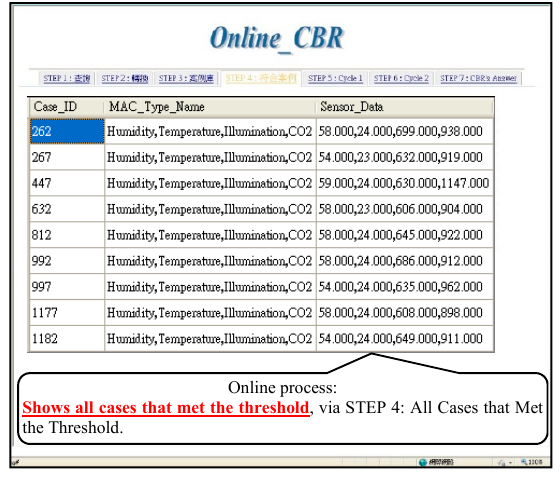
Figure 16. All cases that met the threshold.